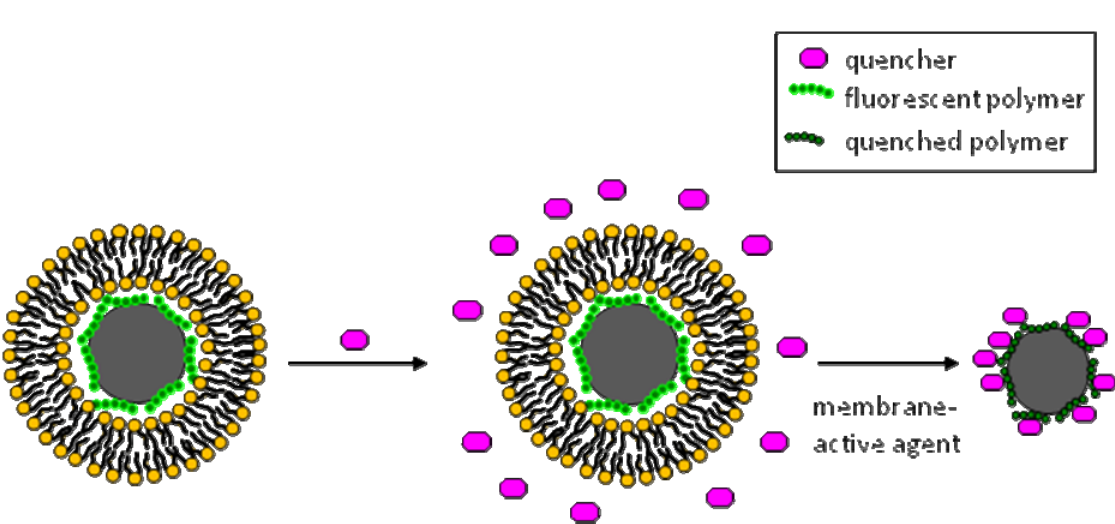
Figure 7. Biosensing of membrane-active agents employing superquenchable polymers. Polymers are deposited on microspheres, then SLBs are formed around them to act as a barrier between the polymer and its quencher. Disrupting the SLB with membrane-active agents permits the close proximity of the quencher and the polymer leading to